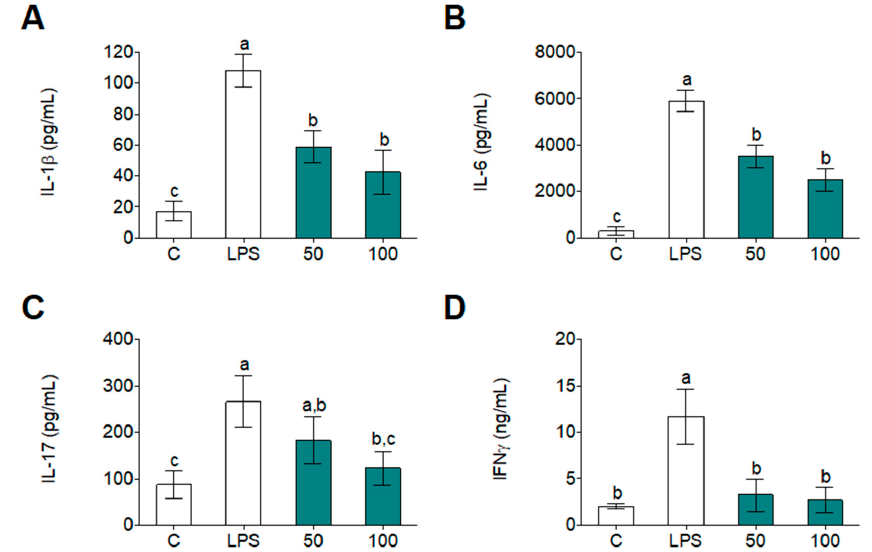
Figure 6. Cytokine secretion of IL-1 β ( A ), IL-6 ( B ), IL-17 ( C ), and IFN γ ( D ) in primary human monocytes after 24 h incubation with or without LPS (100 ng / mL) and WGPH45A at 50 and 100 µ g / mL. Data are expressed as means ± SD ( n = 3) and those marked with di ff erent letters are significantly di ff erent ( p < 0.05).